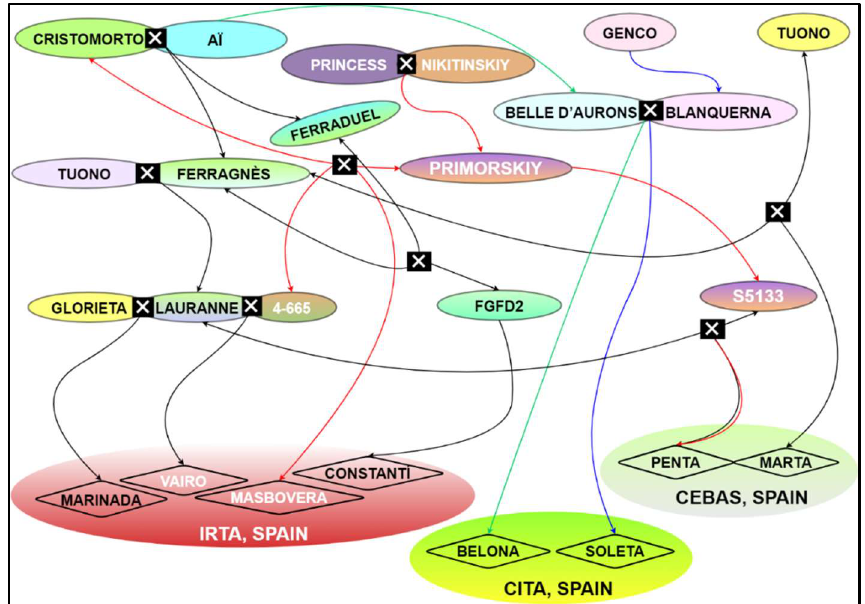
Figure 1. Pedigree of the nine modern almond cultivars analyzed in the present study. This figure must be read from the upper to down. Cultivars descendants of ‘Cristomorto’ × ‘Aï’ are linked using a black line, those from ‘Princess’ × ‘Nikitinskiy’ with a red line, those from ‘Aï’ with a green line and those from ‘Genco’ with a blue line. IRTA = Institute of Agrifood Research and Technology; CITA = Center for Research and Agrifood Technology of Aragon; and CEBAS = Center for Edaphology and Applied Biology of Segura.